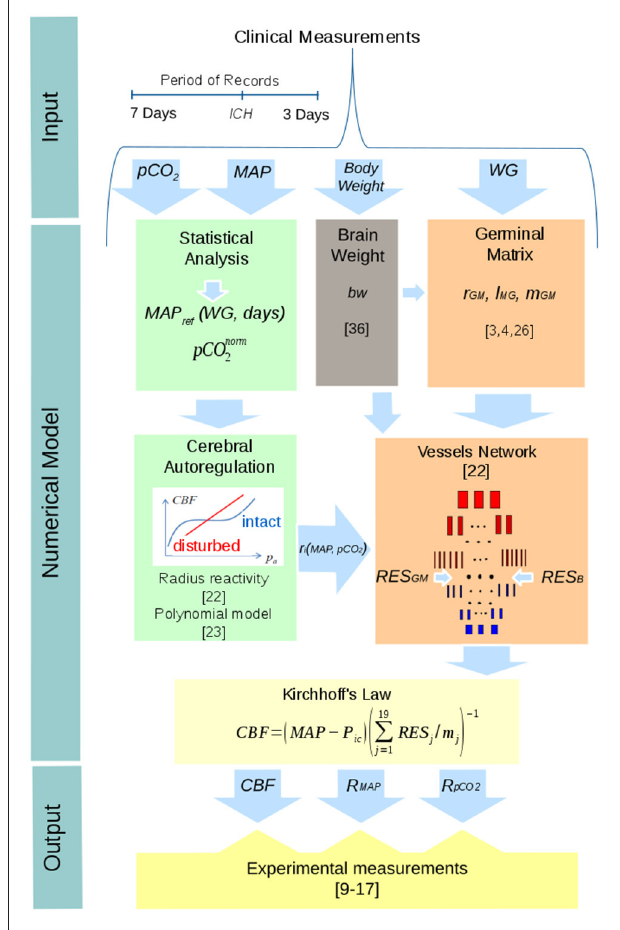
FIGURE 1 | Schematic representation of the numerical model of CBF used in this study and of the procedure used in its validation.